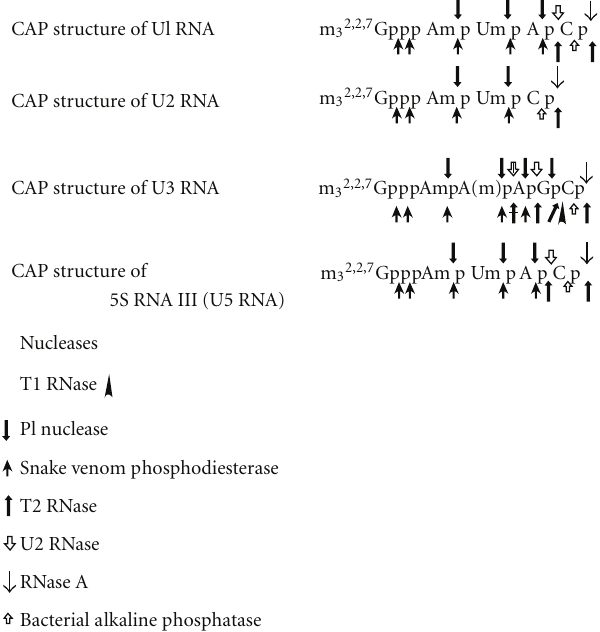
Figure 17: Characterization of m 32,2,7 G caps of snRNAs U1, U2, U3, and U5. The enzyme susceptible bonds are indicated with arrows. The split arrows indicate that some bonds without 2 (cid:2) -O-methylation can be cleaved but the ones with 2 (cid:2) -O-methylated ribose are not.